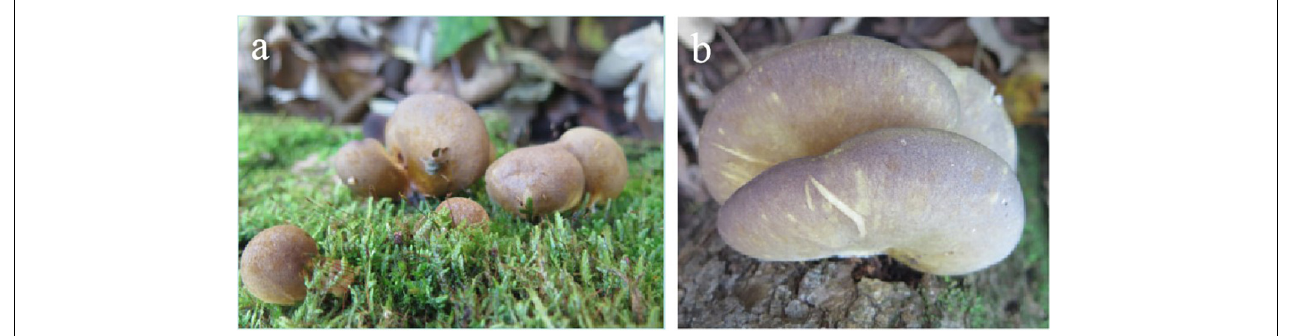
FIGURE 1 | Fruiting body of Sarcomyxa edulis . (a) Developmental stages of S. edulis . (b) Mature S. edulis